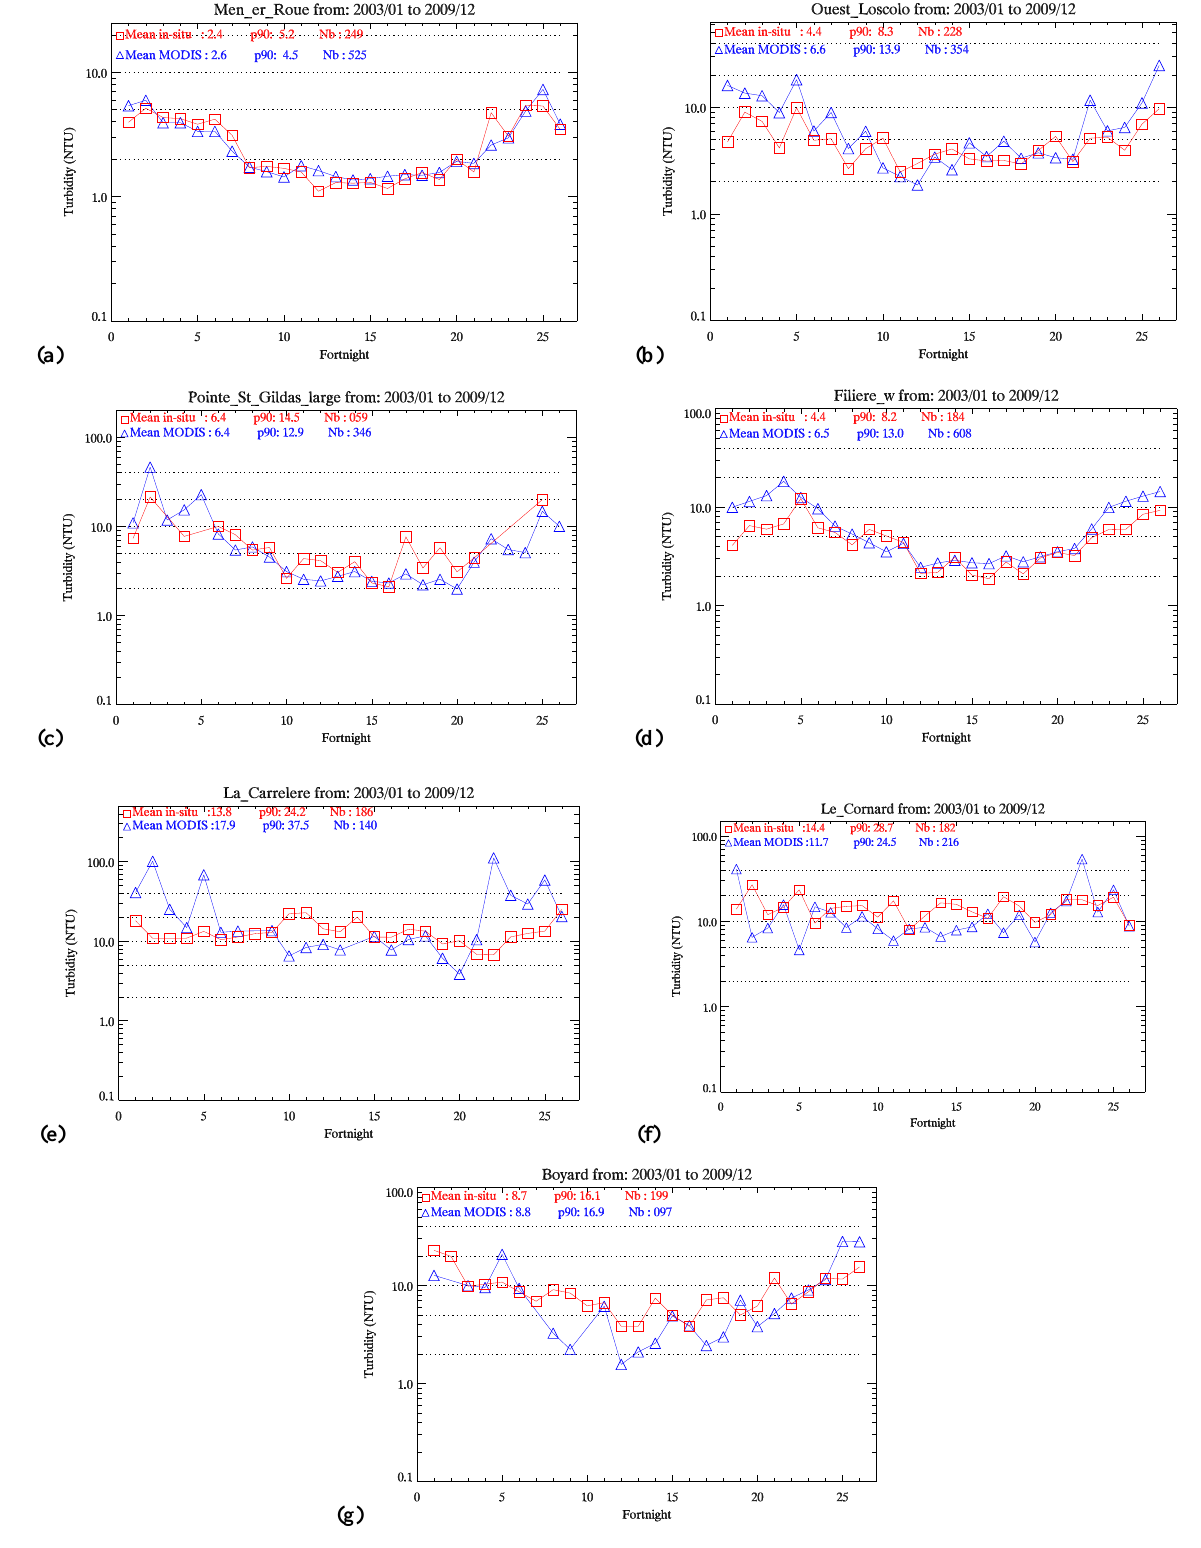
Fig. 12. The annual cycles of turbidity at the selected stations of the Atlantic